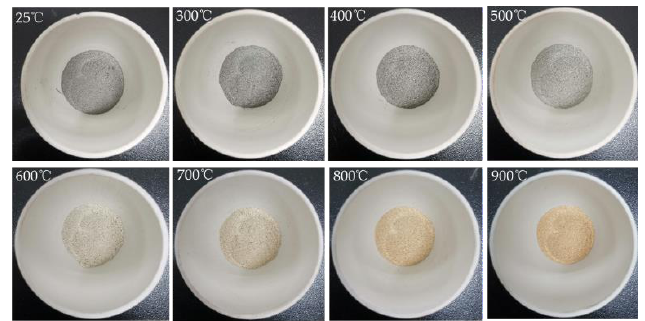
Figure 2. Color change of fly ash heated under different temperatures.